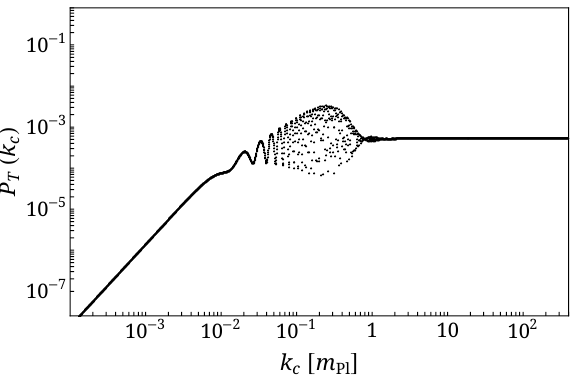
Figure 6. Primordial tensor power spectrum associated with the scale factor evolution with one bounce of negative sign characterized by C = 1, µ = − 400, σ = 2, and B =